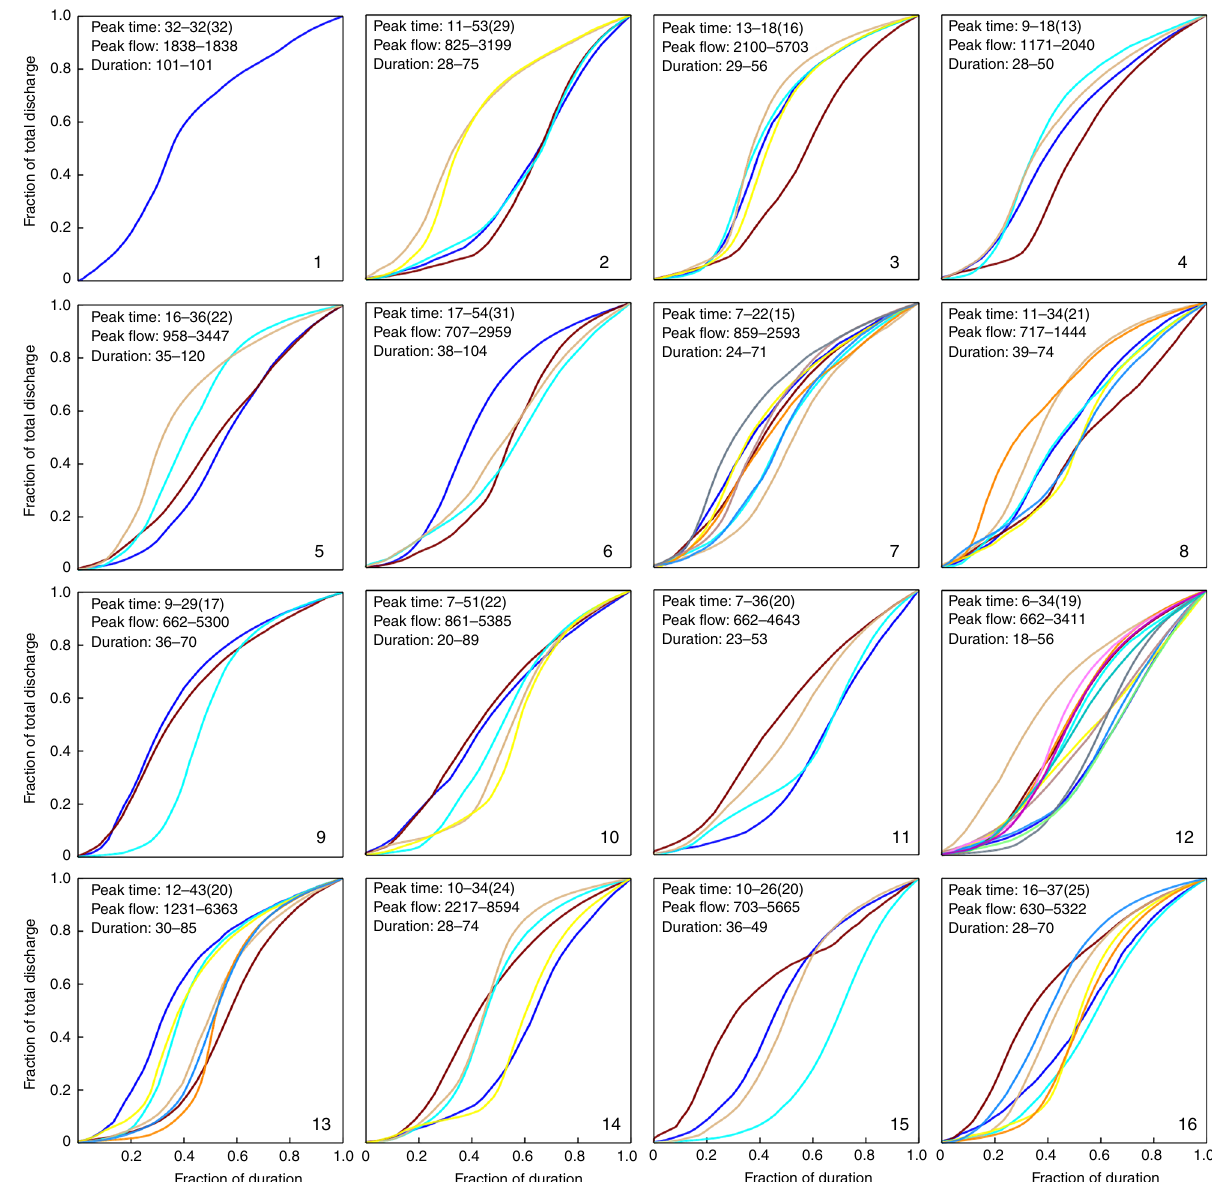
Fig. 5 Normalized fl ow characteristic curves using the second typhoon duration scheme. The second scheme determining typhoon duration spans between the start rising fl ow limb characteristics and the departure of the typhoon from the gridded